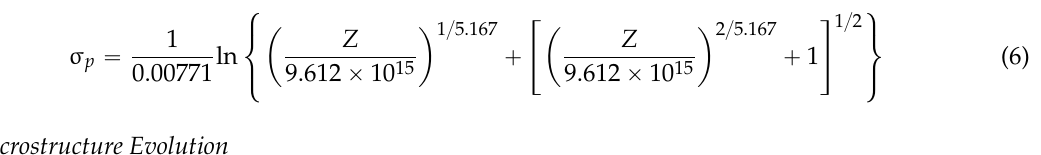
where σ is the flow stress, ε is the true strain, α 1 is dislocation interaction constant relating to dislocation spacing and stress component, G is the shear modulus, and b is the Burgers vector. Based on the Kocks-Mecking model, the apparent hardening depends on the dislocation density which is the result of interplay between storage and annihilation of dislocations as